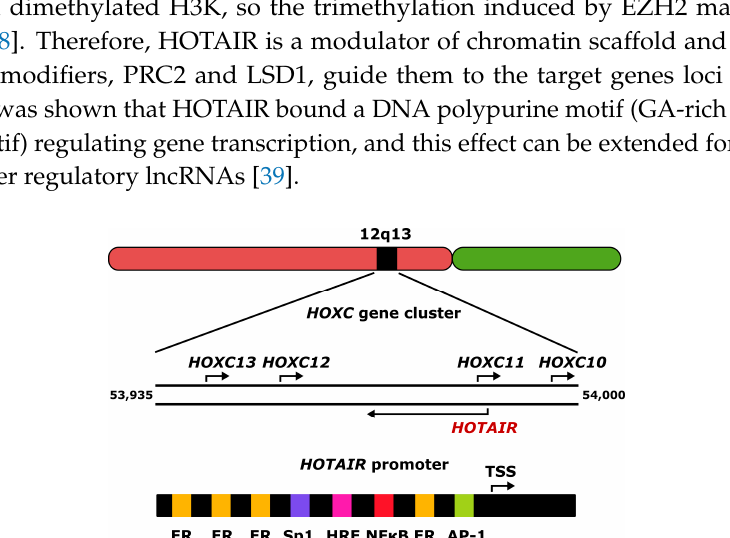
Figure 2. Chemical modifications of chromatin directed by HOTAIR. HOTAIR recruits polycomb